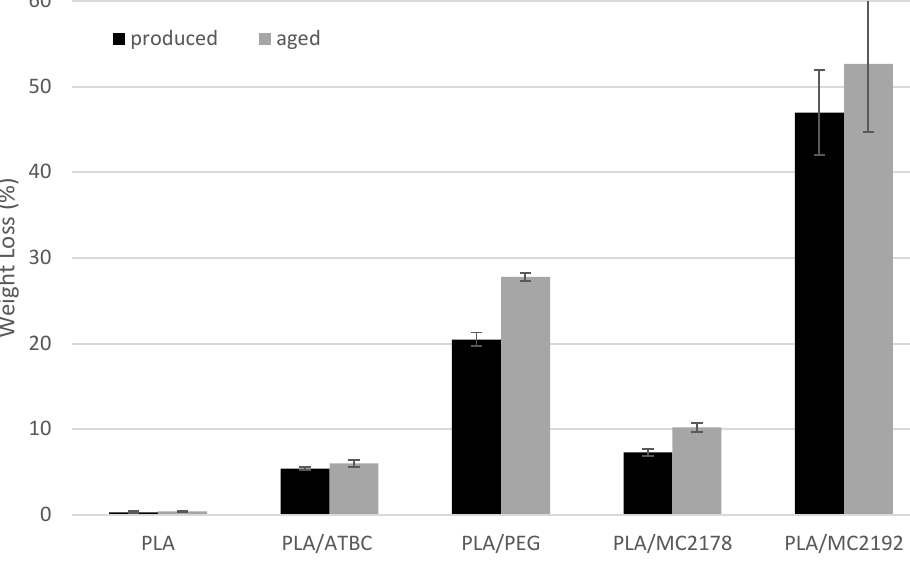
Figure 19. The weight loss of as-produced and aged PLA films after 28 days of composting.